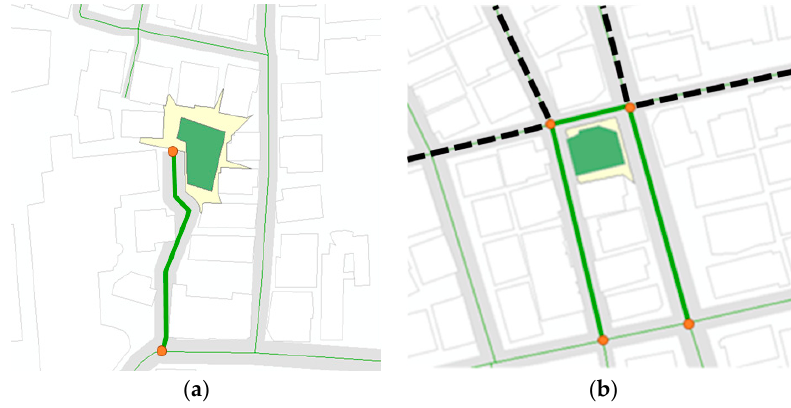
Figure 4. Building layer and road segment matching examples; ( a ) matching to appropriate road segment; ( b ) by using road layer as a barrier, Isovist area from the building at corner matched only to road segments that satisfy the match condition. Otherwise, dashed line could be matched.